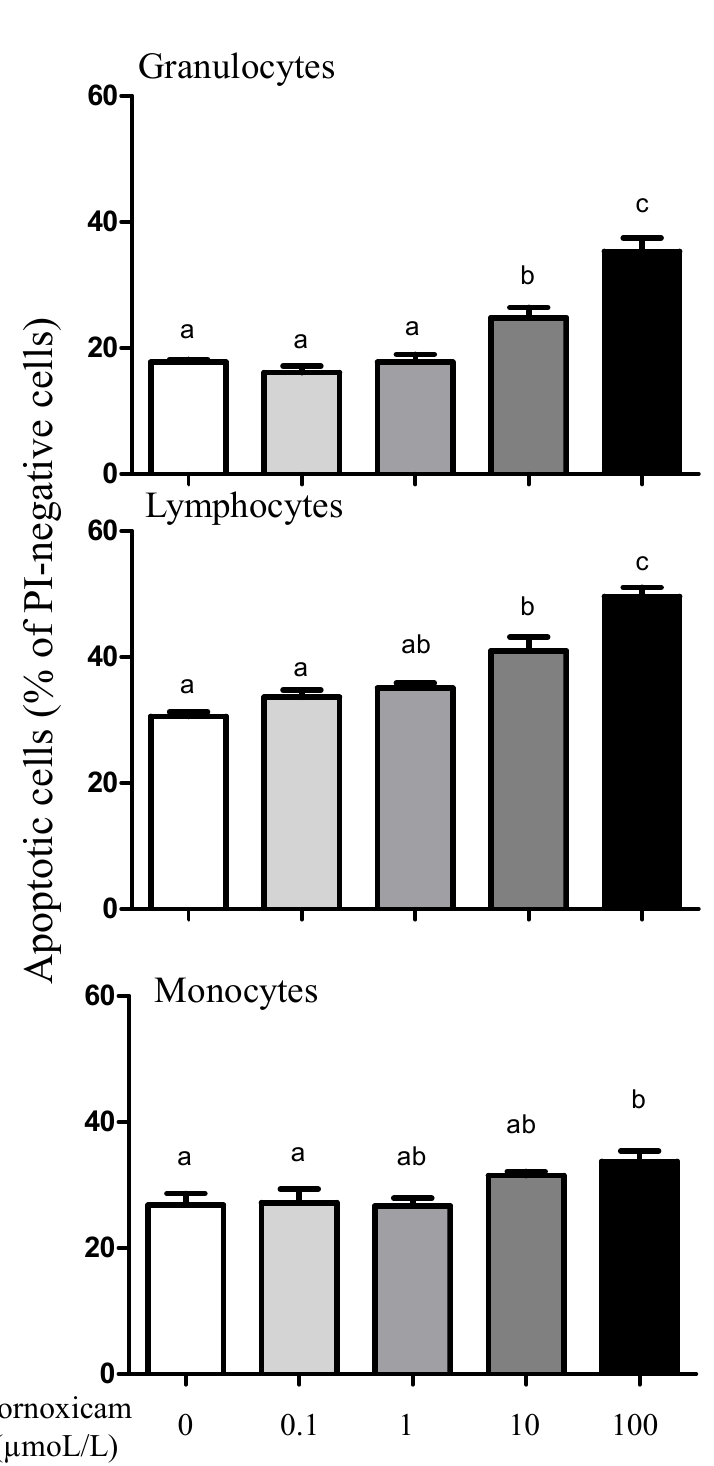
Figure 8. The impact of in vitro incubation with lornoxicam on leukocytes cell apoptosis. Leukocytes were separated from camel blood after incubation with different concentrations of lornoxicam in vitro. Leukocytes were labeled with the JC-1 dye and cell fluorescence signals were measured by the flow cytometer. The fraction of apoptotic cells within the whole populations of granulocytes, lymphocytes, and monocytes was calculated. Significant differences between the groups were indicated by different lower case letters (One-way ANOVA, repeated measures ( p < 0.05)).